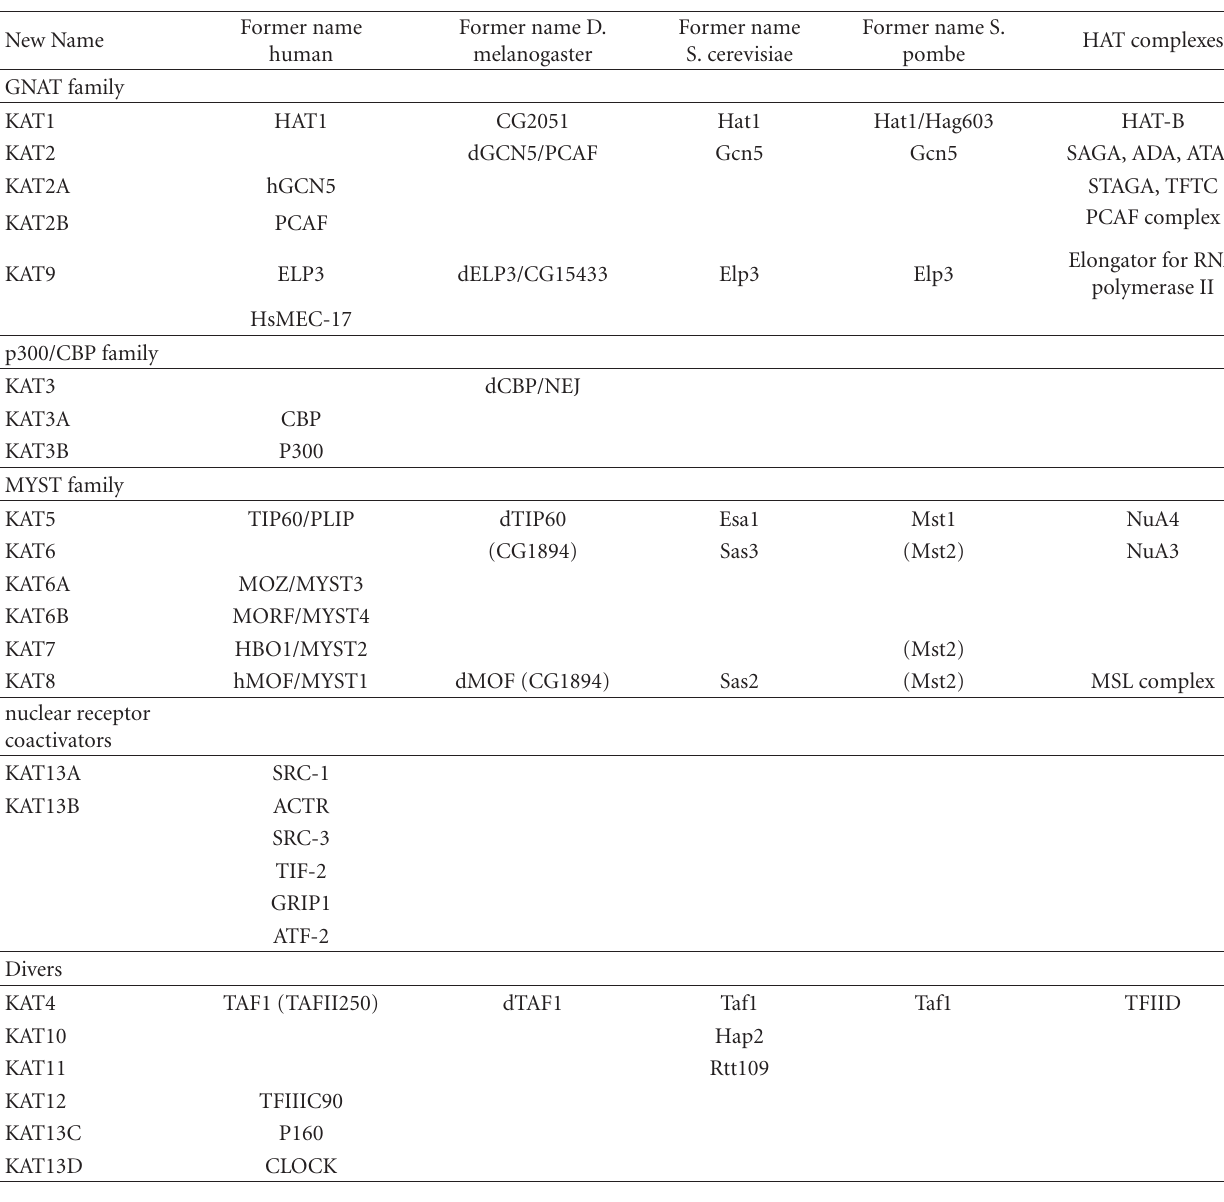
Table 1: Lysine (K)